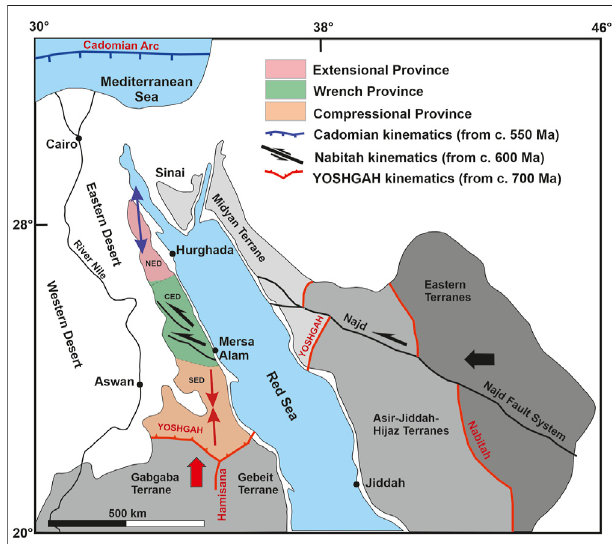
FIGURE 12 | Plate tectonic situation and structural provinces related to different plate kinematics. The earliest event, convergence, and collision between Gabgaba-Gebeit terranes and the Eastern Desert terrane along the YOSHGAH suture released north-south compression (thick red arrow) andrelatednorthandsouthdirectedthrusts(reddoublearrow)inthesouthern compressional province. West — east convergence (thick black arrow) associated with Nabitah Orogeny caused modi fi cation of suture and W-E compression in the Hamisana Belt. In the northern portion, this motion is partitioned into large sinistral strike-slip systems of the Najd Fault System leading to transcurrent motion within the CED wrench province (black half arrows). The retreat of the northern Cadomian arc enabled extension in the northern NED extensional province (blue double